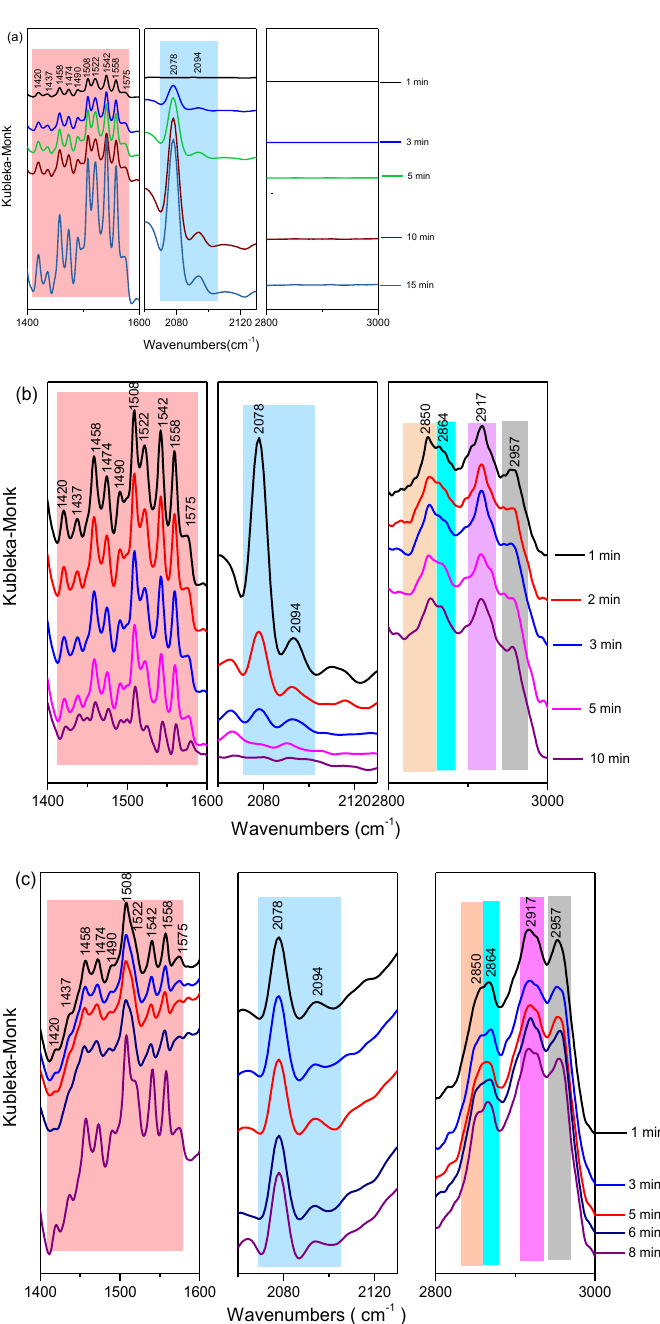
Figure 7. In situ DRIFTS spectra of CO 2 hydrogeantion on MoS 2 -45@C: different feed introduced to catalyst ( a ) CO 2 ; ( b ) H 2 ; ( c ) CO 2 + H 2 . Firstly, the pure CO 2 was introduced into the MoS 2 -45@C catalyst (Figure 7a), and the IR bands at 1420, 1437, 1458, 1522, 1542, and 1575 cm −1 were observed, which were assigned to adsorbed *CO 2 species [59 – 63]. Moreover, IR bands at 1474 and 1558 cm −1 also came into the formation, assigned to bidentate carbonate [59,64], and the signals of monodentate carbonate species were prevalent at 1490 and 1508 cm −1 [64,65]. Addition- ally, their intensities were increased by prolonging the contact time of CO 2 and